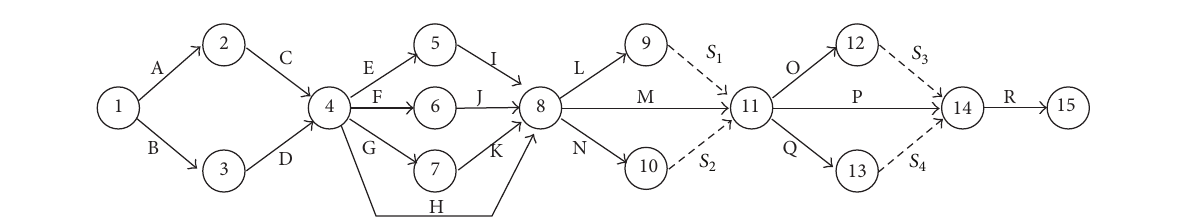
Figure 1: Project network